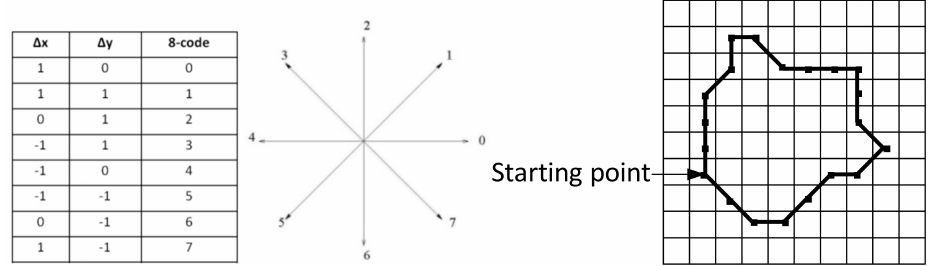
Figure 5. Eight-directional Freeman chain coding and a boundary of a typical binary image expressed by the code